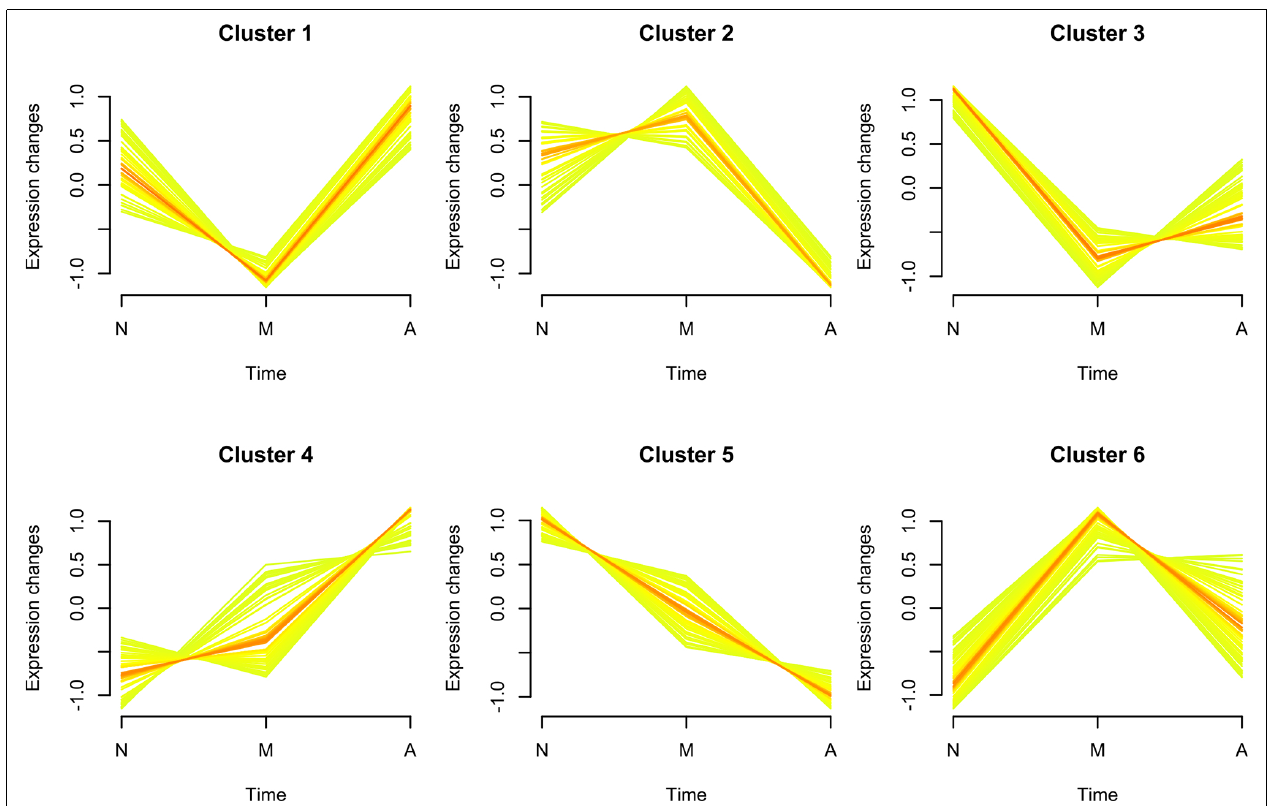
FIGURE 2 | Soft clustering of exosomal protein expression patterns. The membership values of each cluster protein are color-encoded in the plots. Yellow- or green-colored trend lines correspond to bridge proteins with relatively low membership value, whereas their red-colored counterparts represent bridge proteins with higher value of membership. Three characters “N,” “M,” and “A” on the horizontal axis represent normal, mild cognitive impairment (MCI) and Alzheimer’s disease (AD). The six soft clusters exhibit distinct expression patterns of neuron-derived exosomal proteins across the different stages of AD progression, among which Cluster 4/Cluster 5 display a consistently increasing/decreasing